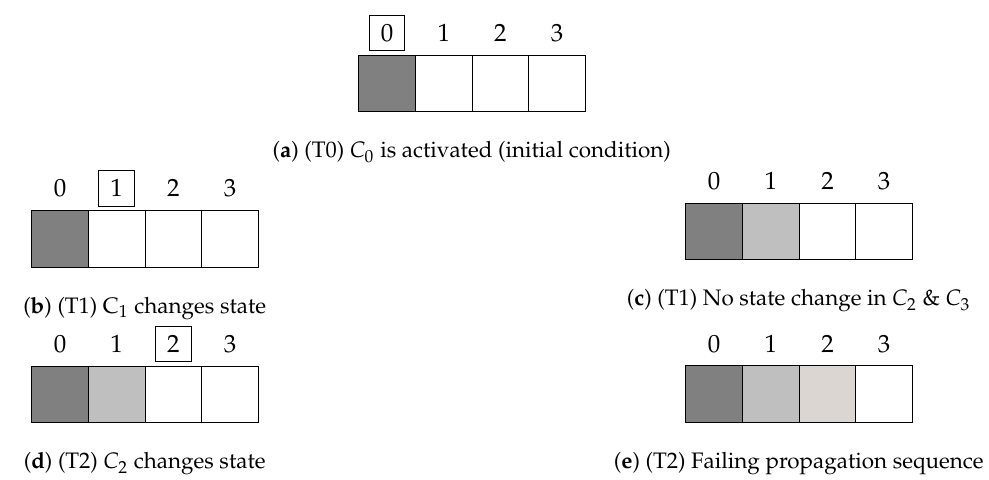
Figure 1. Schematic propagation in a 4-cell-HCA with vanishing activation wave